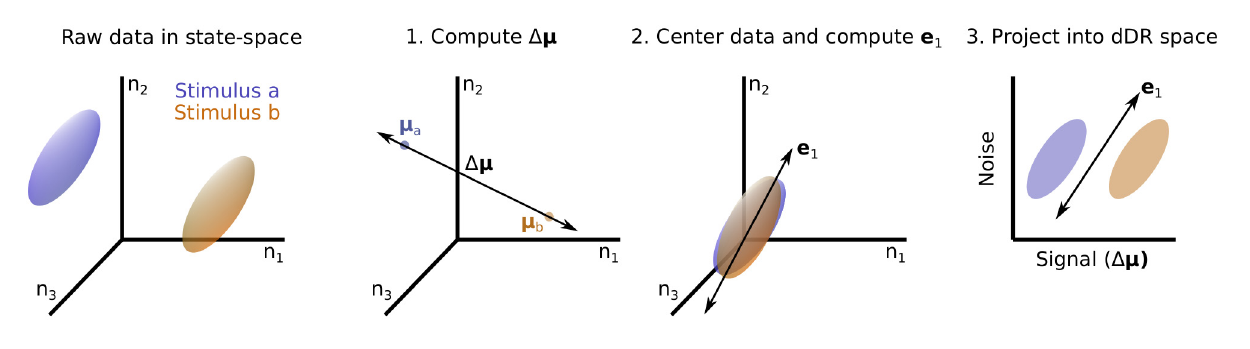
Fig 4. Decoding-based Dimensionality Reduction ( dDR ). Left to right: Responses of 3 neurons ( n 1 , n 2 , n 3 ) to two different stimuli are schematized in state- space. Ellipsoids illustrate the variability of responses across trials. 1 . To perform dDR , first the difference is computed between the two mean stimulus responses, Δ μ . 2 . Next, the mean response is subtracted for each stimulus to center the data around 0, and PCA is used to identify the first eigenvector of the noise covariance matrix,